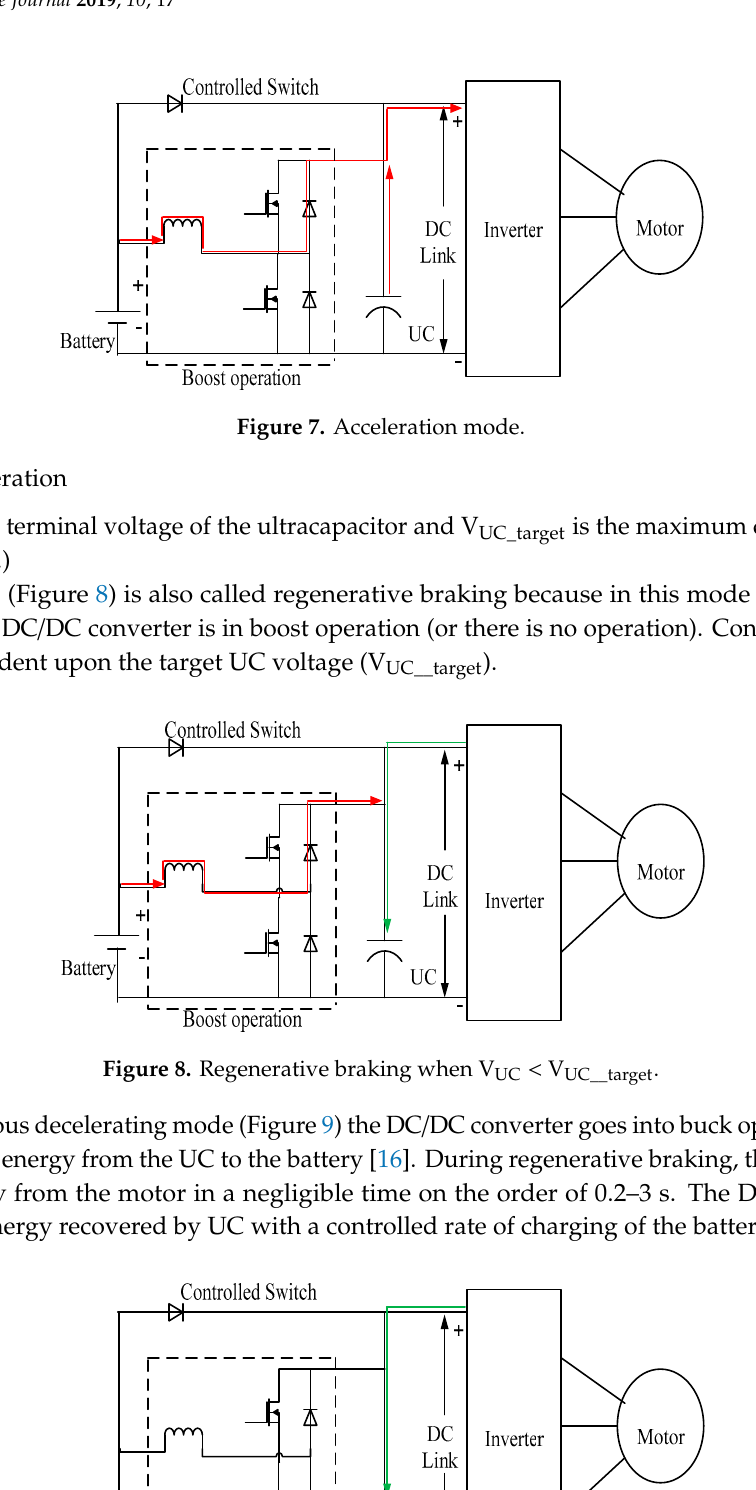
Figure 9. Regenerative braking when V UC > V UC_target .